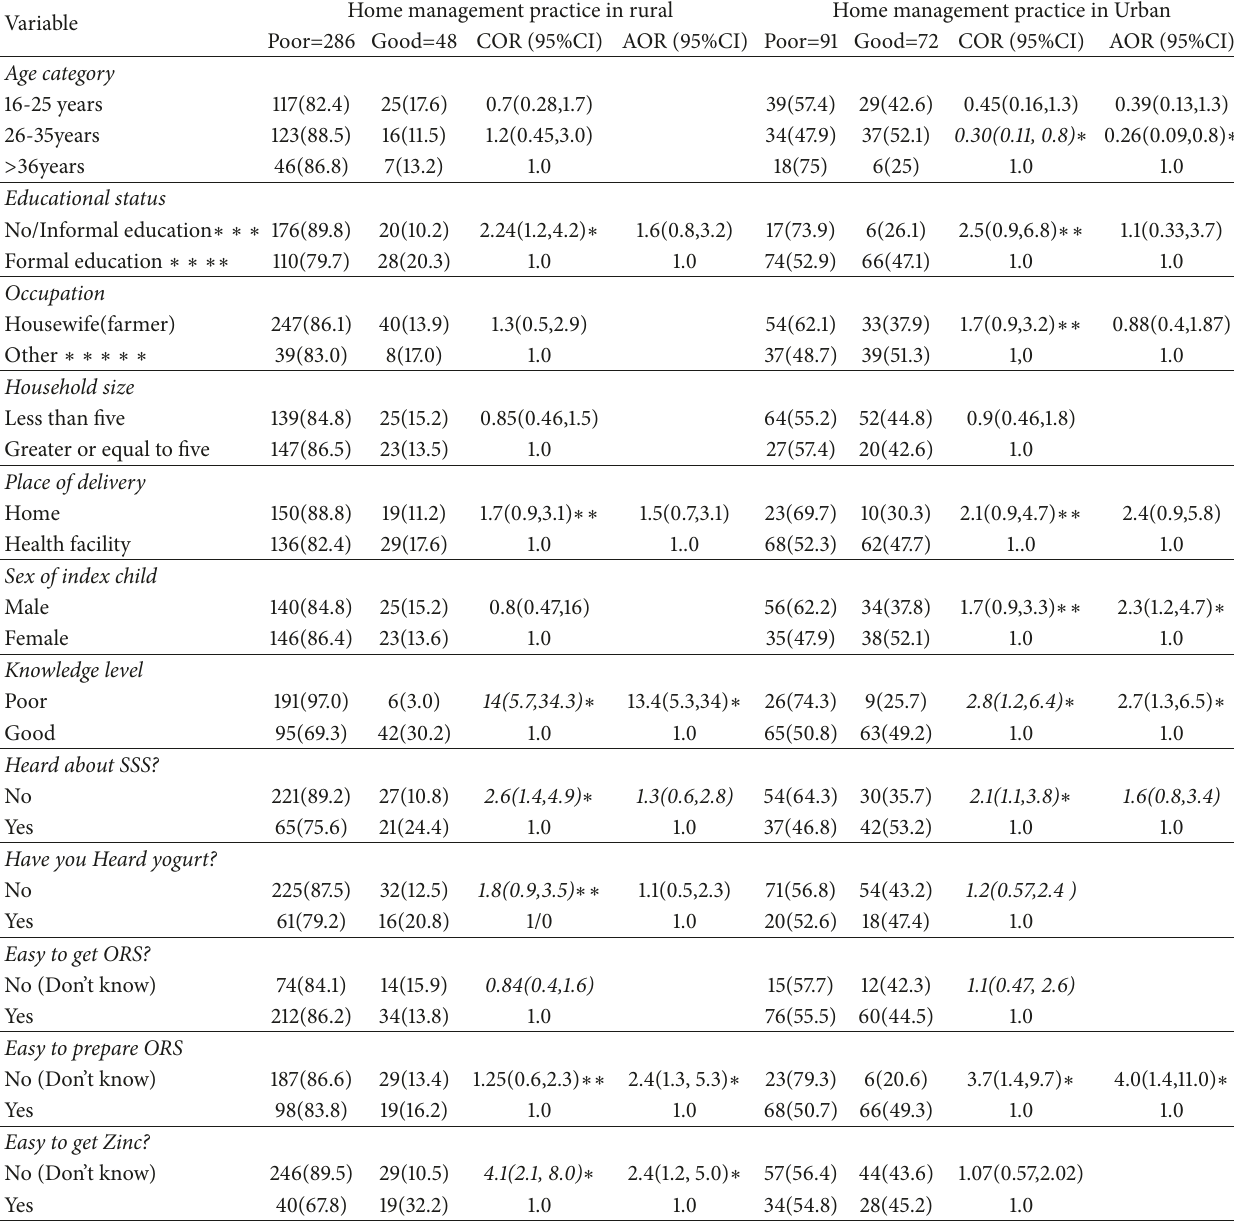
Table 7: Associated factors of poor home management practice of diarrhea among caregivers of under-five children in urban and rural resident of Doba Woreda,